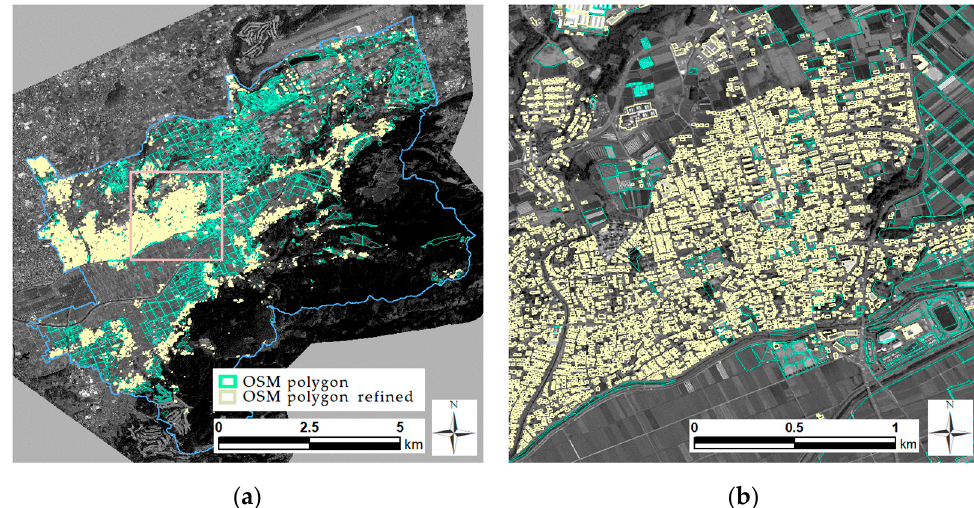
Figure 3. OpenStreetMap (OSM) [19] polygons and OSM data refined by attribution: ( a ) The whole view on Mashiki town and ( b ) zoomed-in view of the rectangle area.